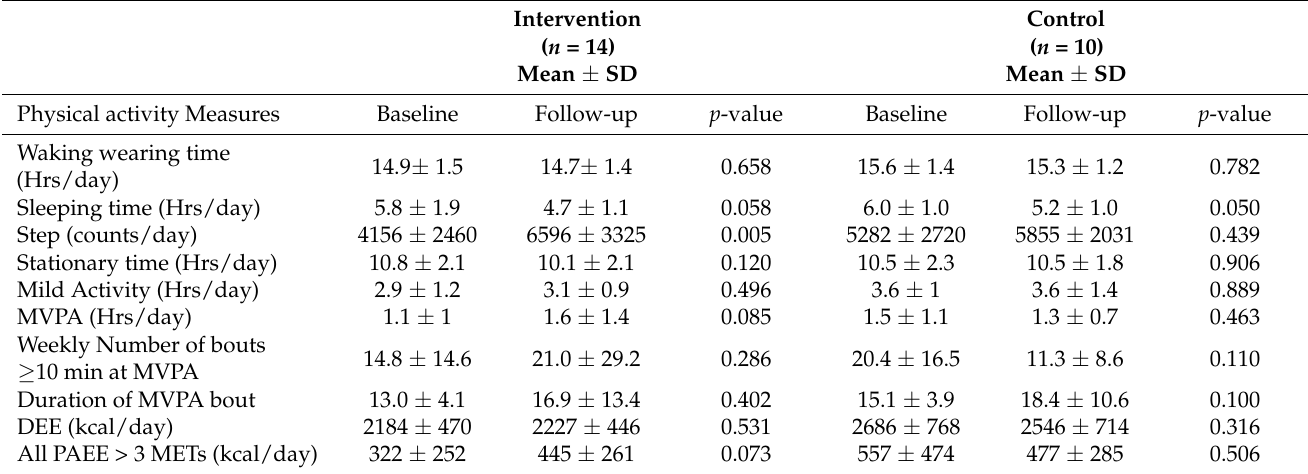
Table 2. Comparisons of physical activity measures within groups at baseline and